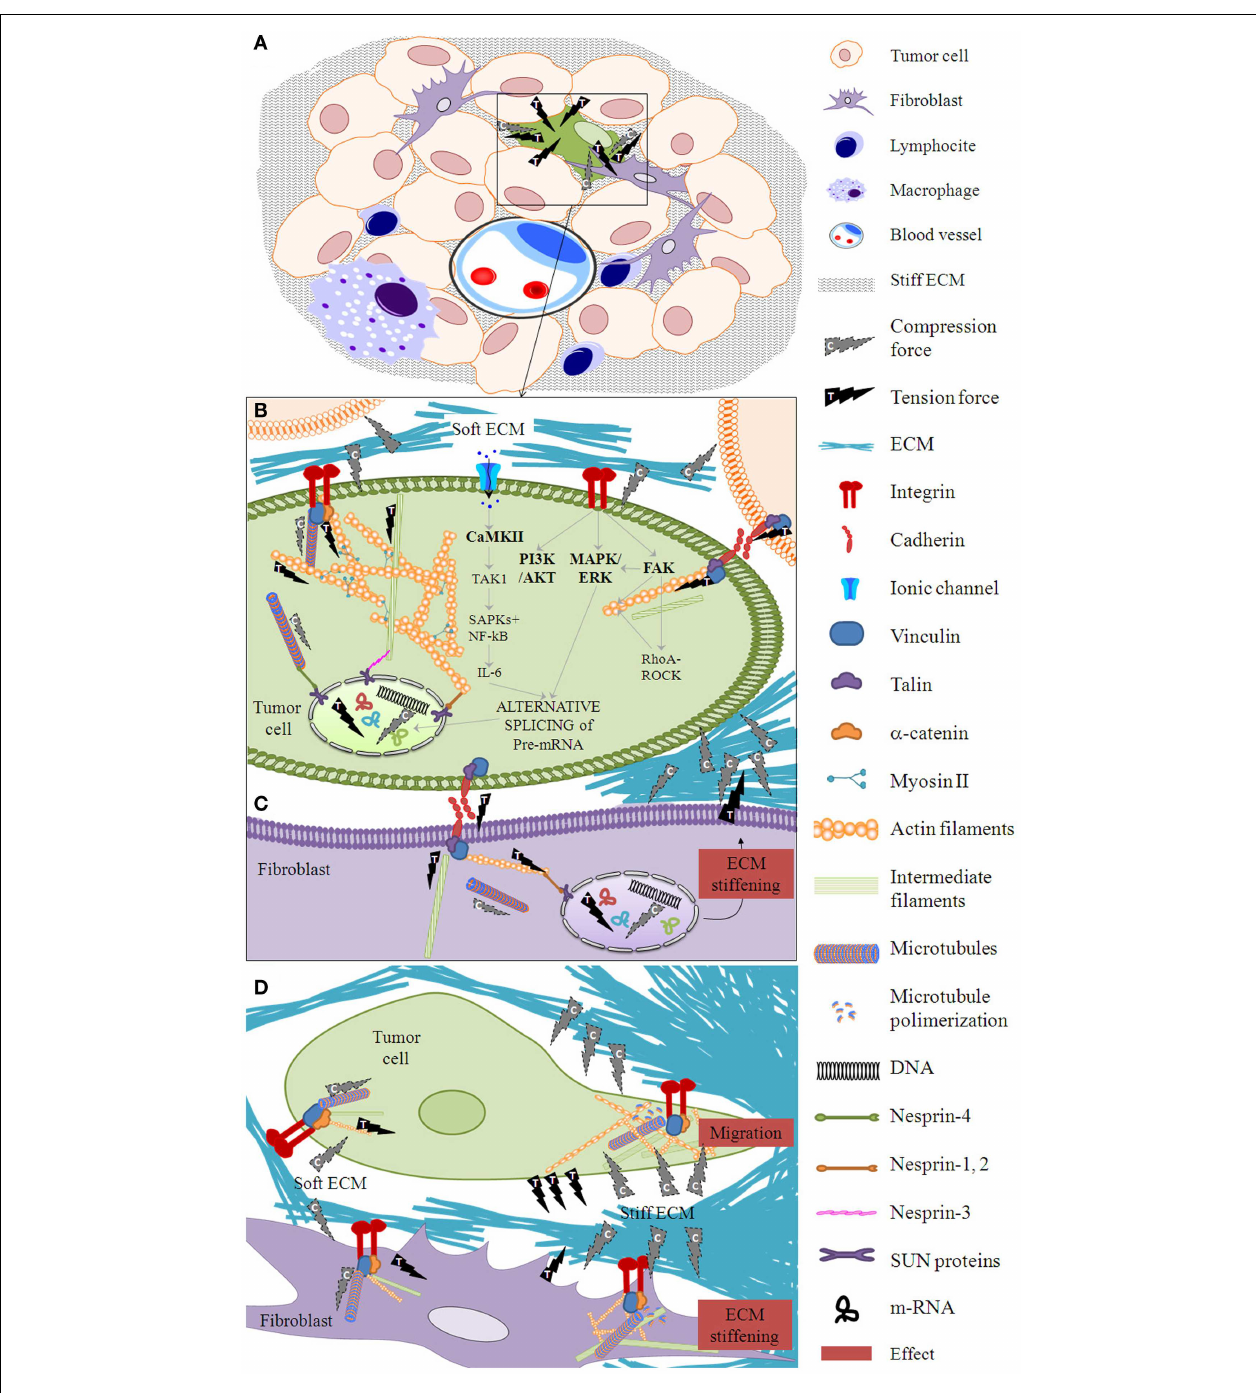
mechanisms. Some essential players in mechanosensing are shown (44–47). (C) The biochemical signal is transmitted to neighbor cells (marked in purple) through cell–cell junctions. Following the principle of tensegrity at the cell level, the compression elements are the microtubules, whereas the tension elements are the intermediate filaments and the actin filaments. (D) A fibroblast neighbor cell can produce a stiff ECM which in turn enables the first cell to flatten and migrate through this stiffened ECM.The effector cell response phase arises from the biotensegrity principle: a simple cytoskeleton when the ECM compression is low switches to a complex cytoskeleton when the ECM exerts high compression on the cells and the cells exert high tension on the